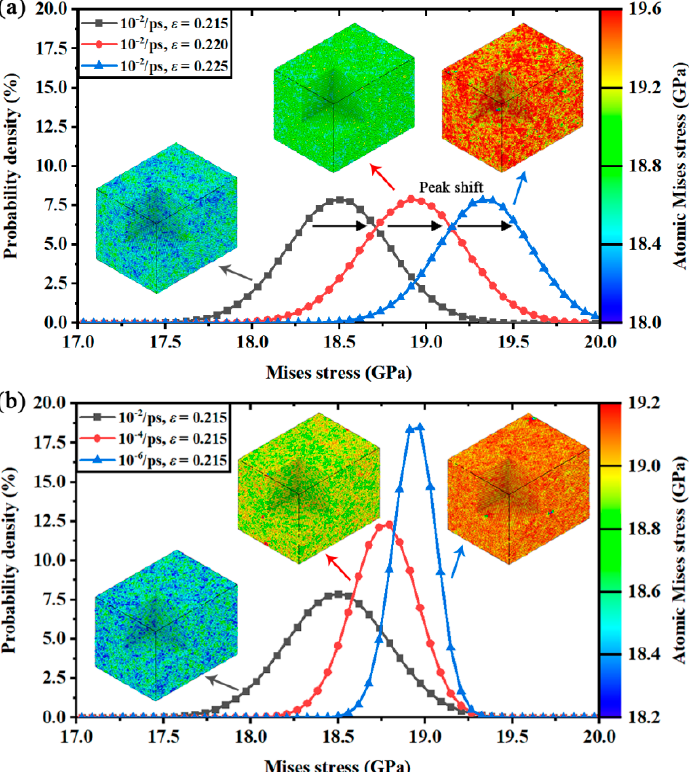
Figure 8. Probability density of von Mises stress distributions in Mono-Si: ( a ) at three different applied strains and equal strain rates; ( b ) at three different strain rates and equal applied strains.